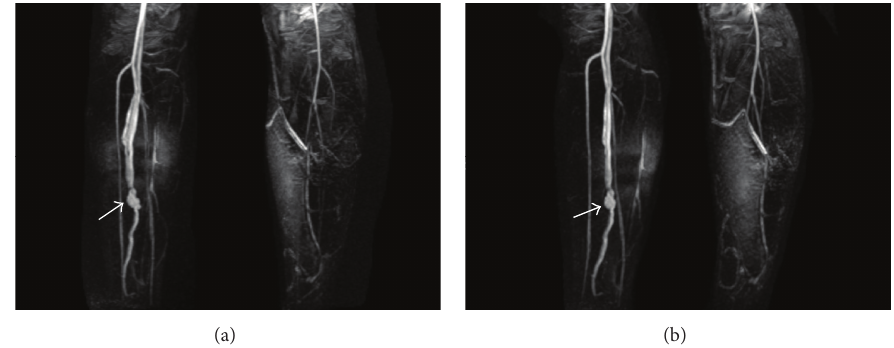
Figure 3: MR angiogram with contrast. (a) AP and (b) oblique images demonstrate the peroneal artery pseudoaneurysm and early filling arrows of the venous